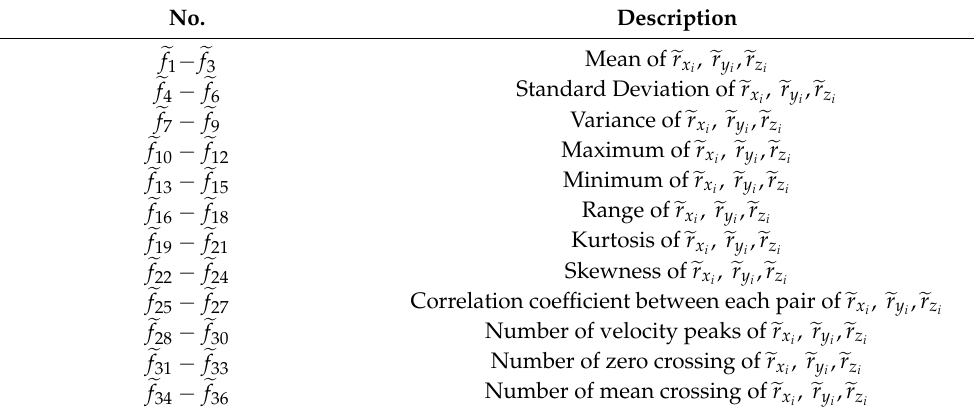
Table 3. A list of statistical and kinematic feature types from a single sensor. No. Description